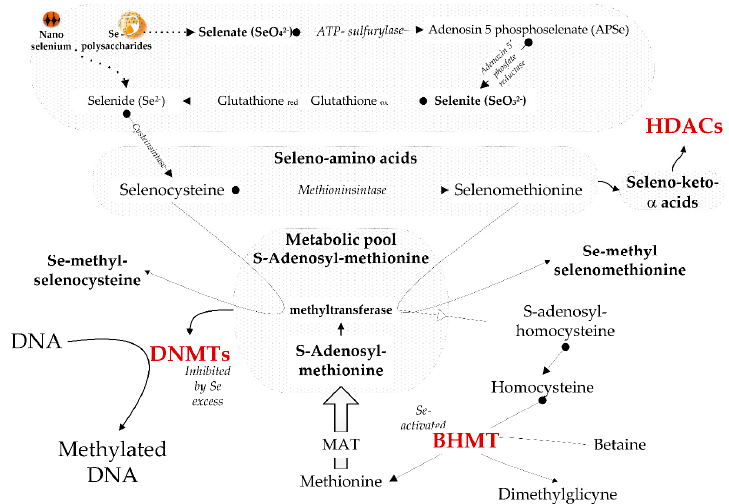
Figure 3. Next-generation Se supplements and their (potential) moderate epigenetic effects. In red are enzymes influenced by Se level. A low level of Se disturbs one-carbon metabolism and S -adenosyl methionine restoration, because betaine homocysteine methyltransferase (BMHT) needs higher levels of selenium for optimal activity. A high level of Se leads to inhibition of DNA methyltransferases (DNMTs) and to competition for methyl groups, needed to produce methylated selenium amino acids. Excess selenium influences histone deacetylation and further cross-talk with DNA methylation. The seleno-amino acids are converted via transamination to seleno-keto- α -acids, which inhibit histone deacetylase (HDACc). Zerovalent selenium and selenium polysaccharides slowly release active selenium species via an equilibrium reaction. The rate of such an equilibrium reaction depends on consumption of the reaction products. In tissues of subjects with a normal/optimal selenium status, the consumption of the reaction products is lower and the release of active selenium species over the optimal status is slower. At a deficit-to-optimal level of intake, the selenium species are rapidly used for the expression of the deficit amino acids and seleno-proteins, and the rate of release is higher. The